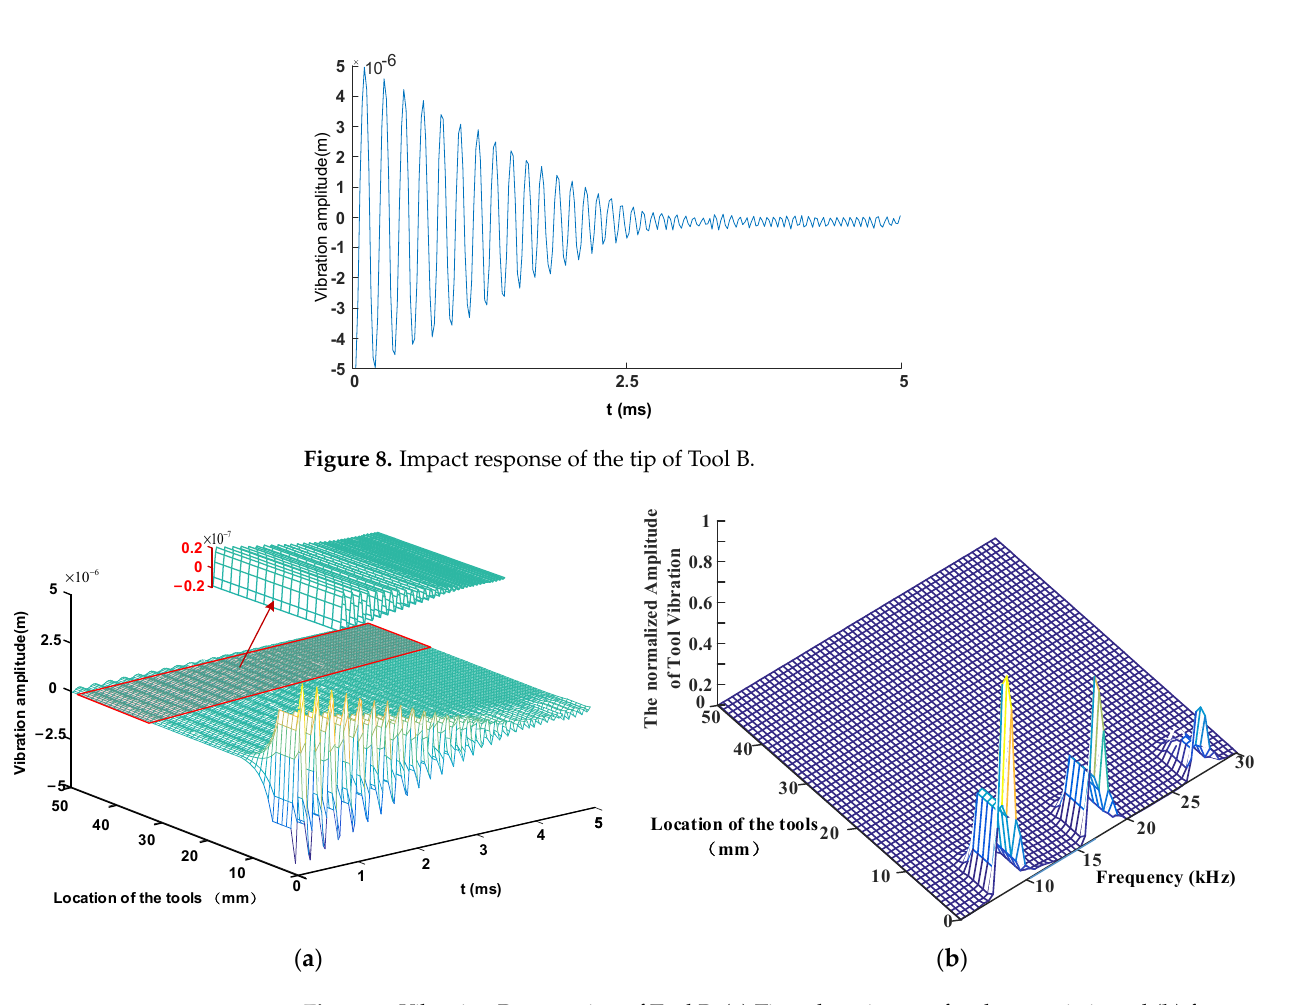
Figure 9. Vibration Propagation of Tool B. ( a ) Time domain transfer characteristic and ( b ) frequency domain transfer characteristics.